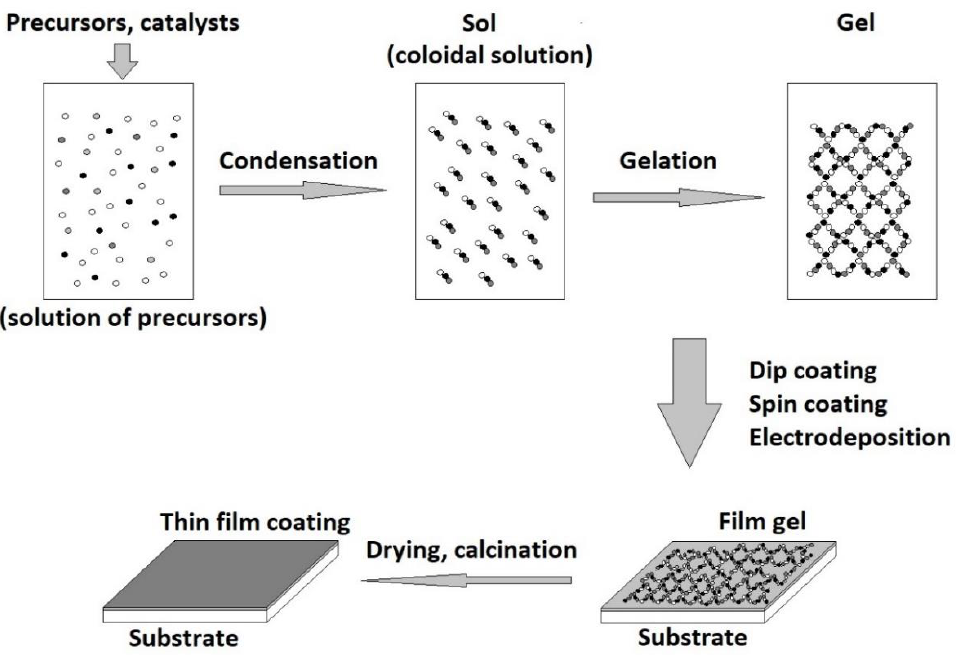
Figure 3. Sol-gel coating